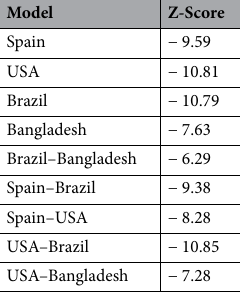
Table 6. Wilcoxon signed rank test Z-score of the models with respect to Spain-Bangladesh